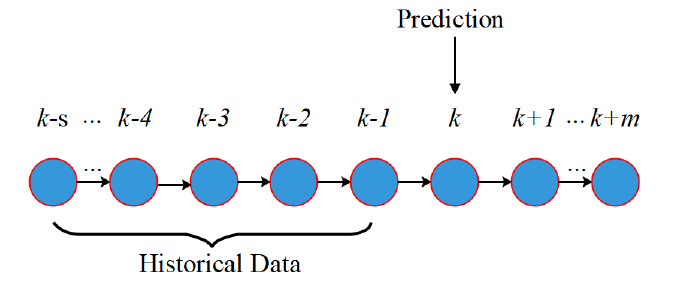
Figure 10. Time series